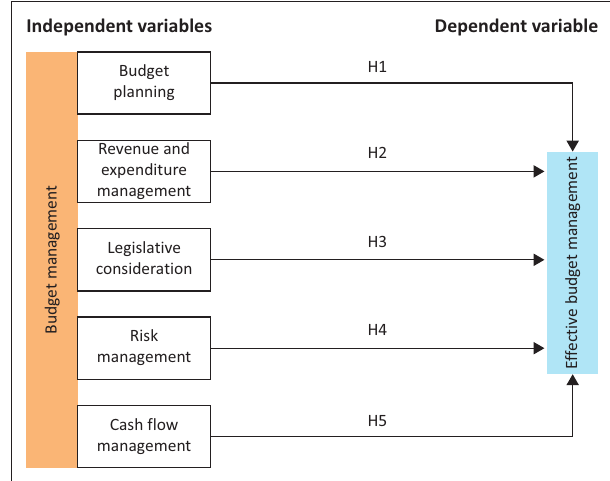
FIGURE 2: A proposed hypotheses development